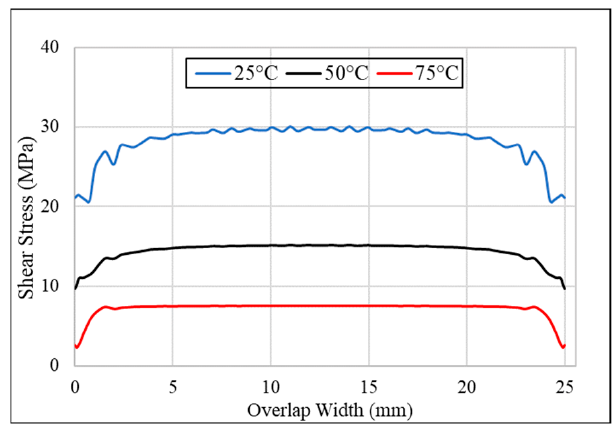
Figure 20. Shear stress distribution at location C of SLJ with Al 2 O 3 nanoparticles in the adhesive at different temperatures.